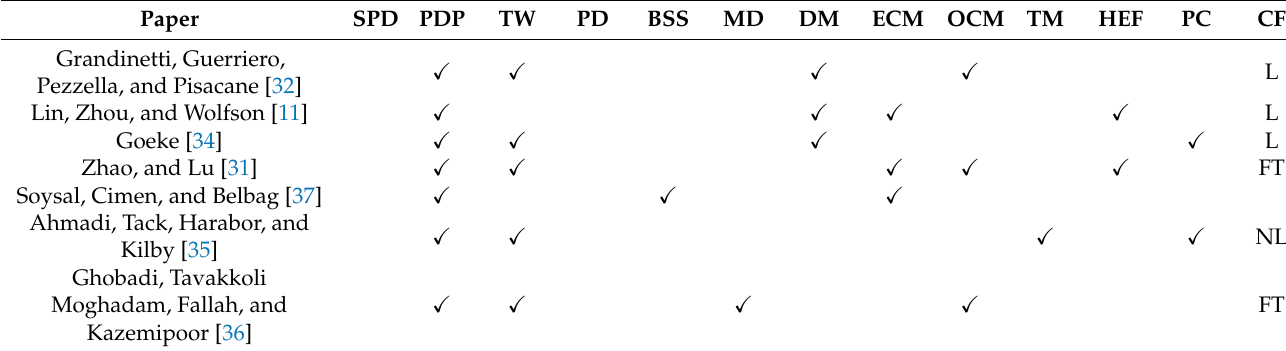
Table 1. EVRP with pickup and delivery in the